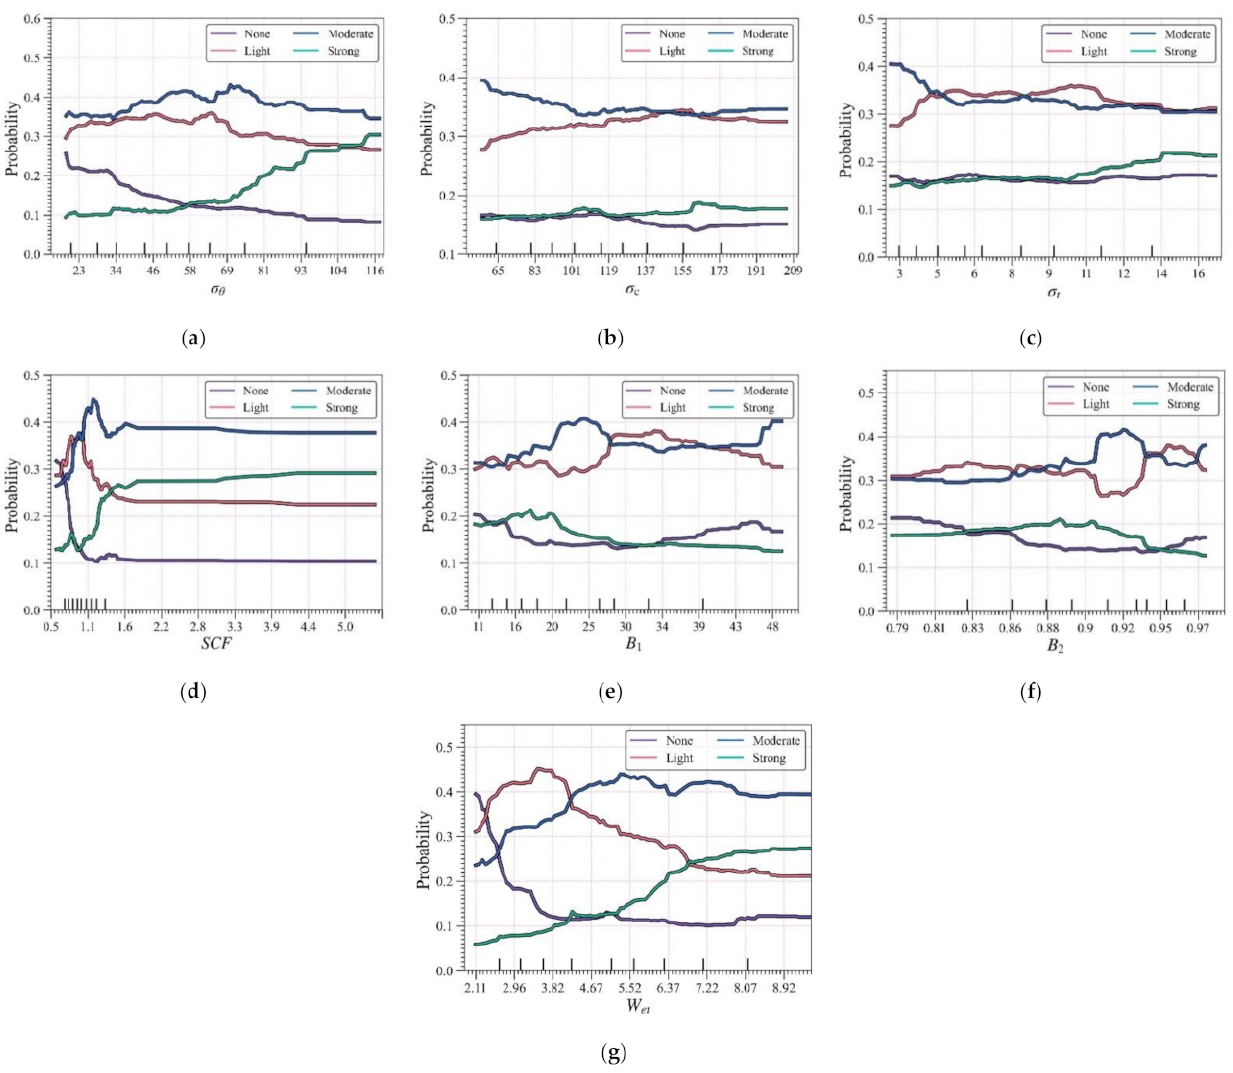
Figure 13. PDP to analyze the influence of variables on the rockburst predicted probability. ( a ) σ θ ;